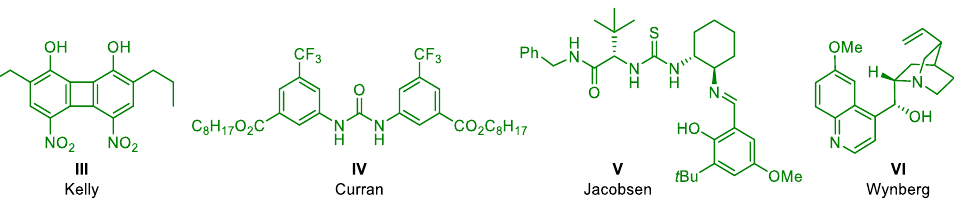
Figure 1. Crucial organocatalytic structures reported previously to 2000.